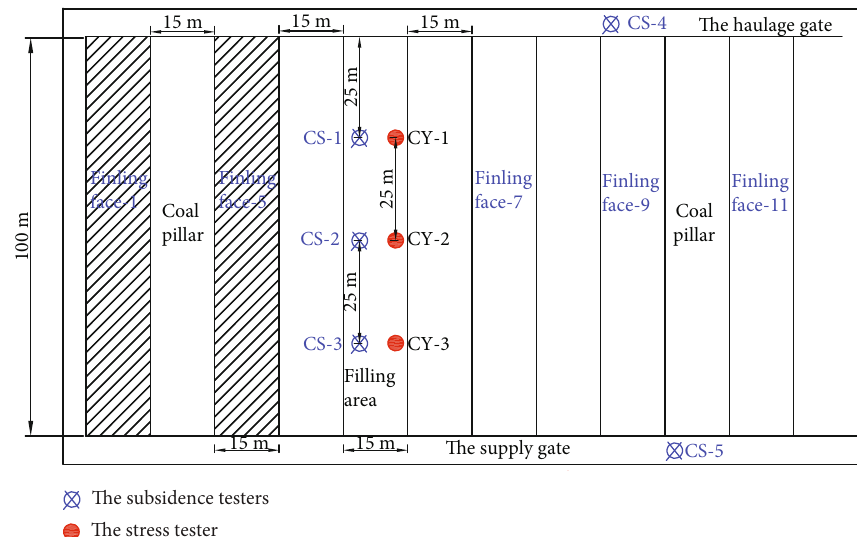
Figure 12: Layout of stress and subsidence gauges.